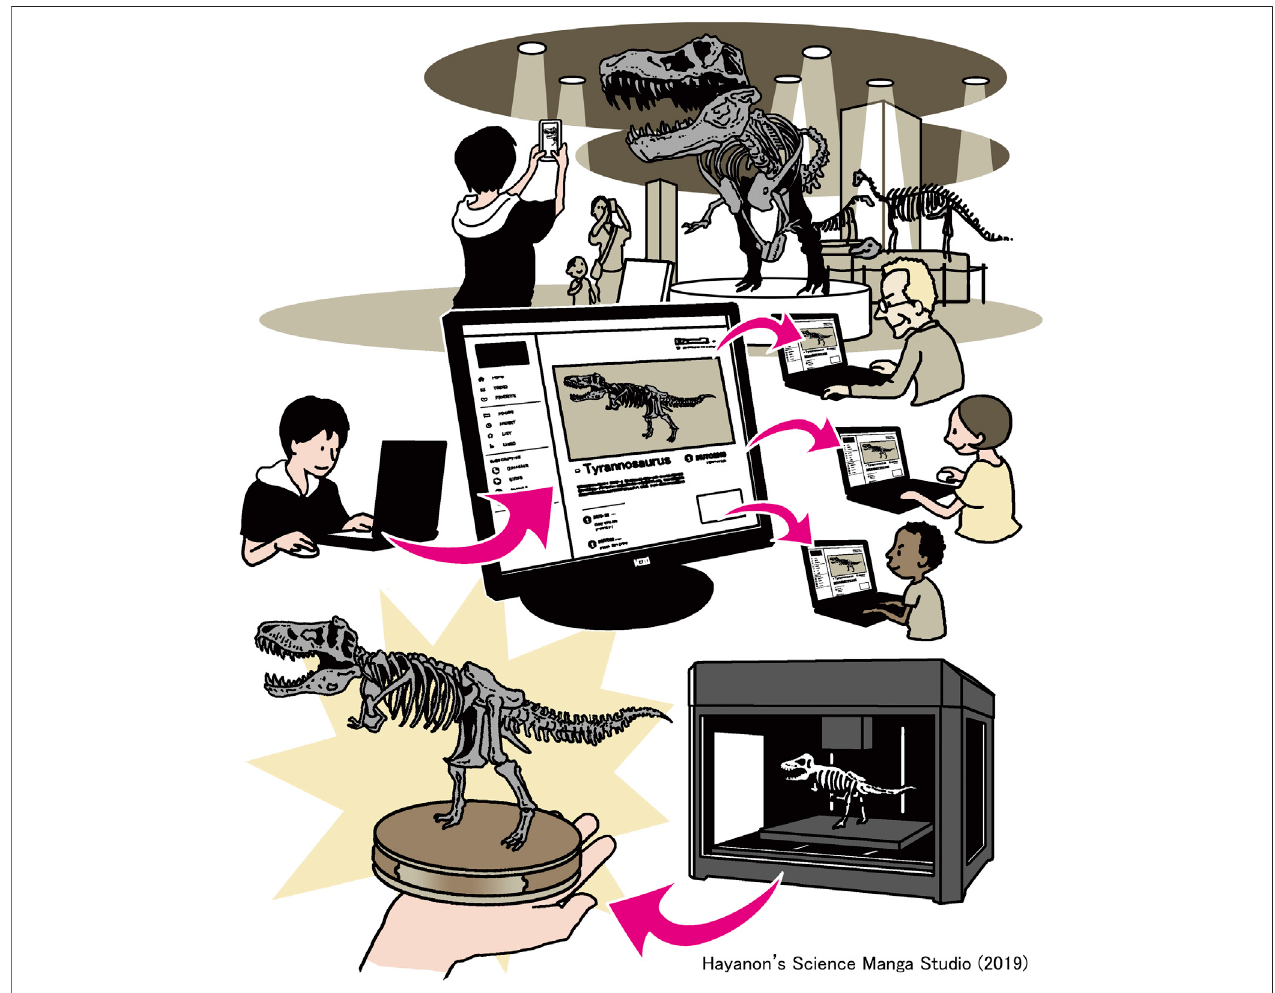
FIGURE4| Fromphotographsofamuseumexhibittoa3D-printedproductinhand.Innovationandcostreductioninphotogrammetry canassistmuseumvisitors in making 3D digital models based on photographs taken in the exhibition hall without breaking museum policies and allow them to publish these to sharing platforms. Illustrated by Hayanon, Hayanon ’ s Science Manga Studio (https://www.hayanon.jp/).